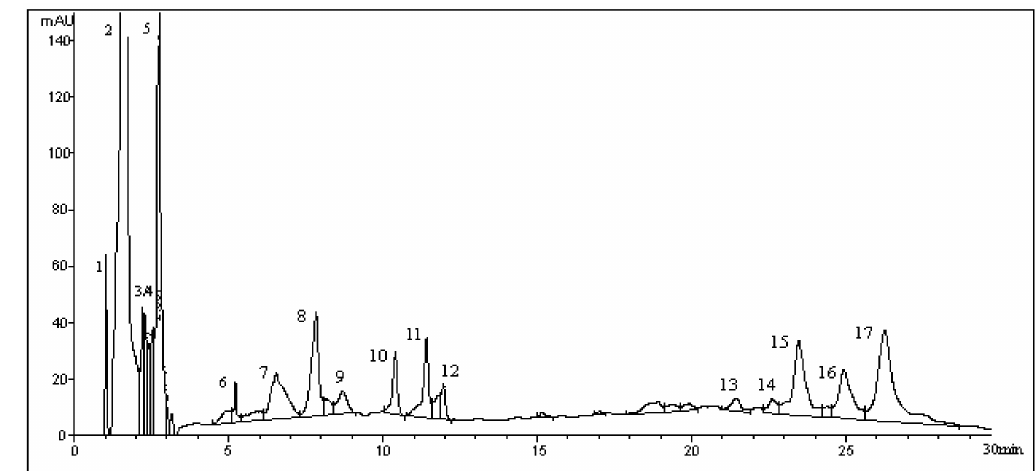
Figure 2. HPLC profile recorded at 255 nm. Biebersteinia heterostemon bark antihypertensive fraction (GAP). Compound 4 was obtained as colorless, needle-like crystals. m.p. 104~105 ◦ C.